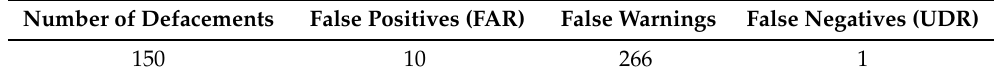
Table 1. Accuracy in the newspaper scenario.